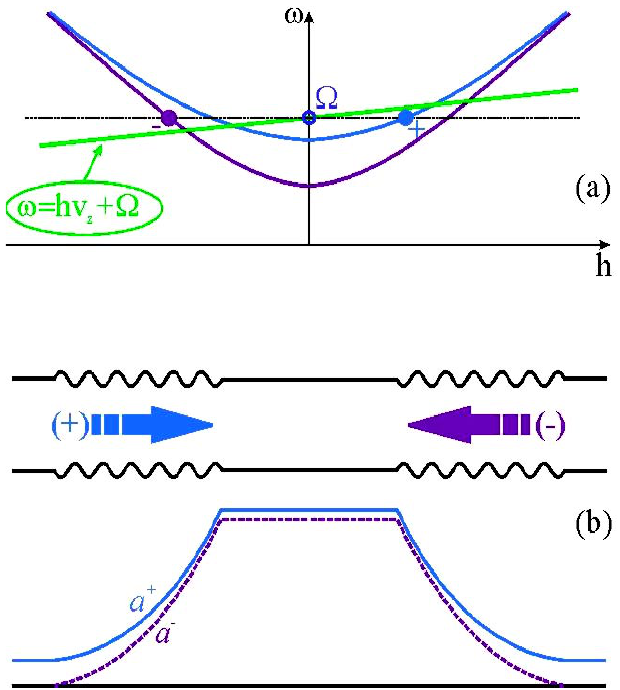
FIG. 4. (Color) Dispersion diagram for the case of the averaged two-wave resonance (a) and longitudinal structure of forward and backward waves inside the microwave system of the bunch- ing section